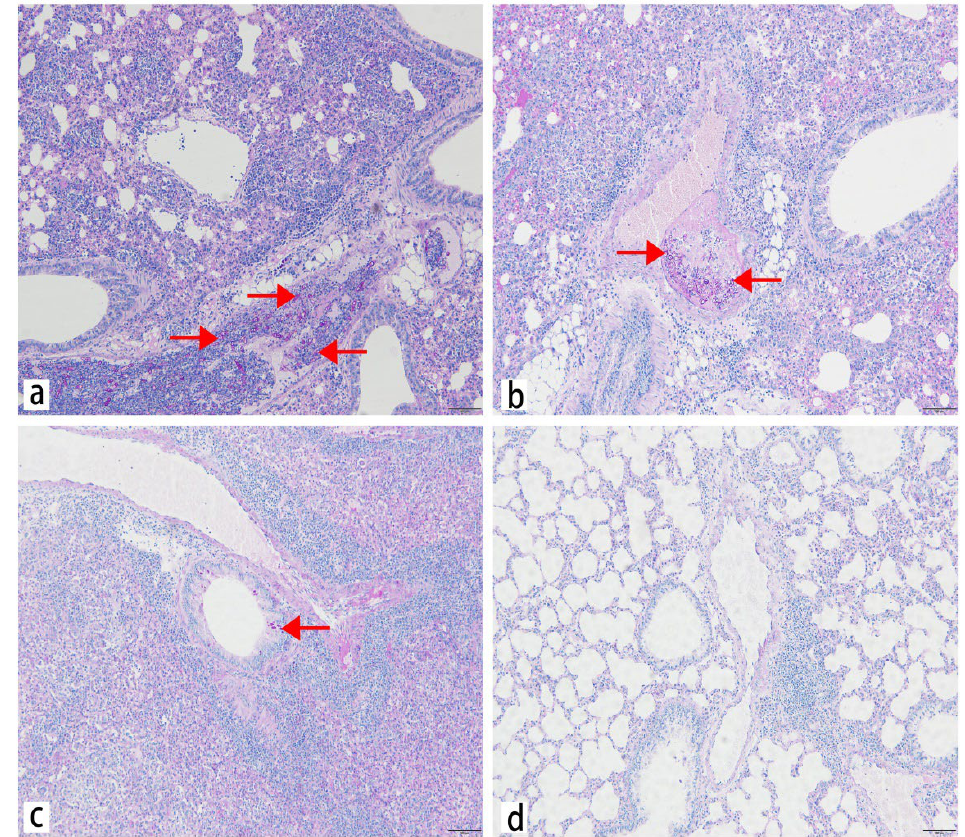
Figure 4. Representative PAS-stained sections of lung from mice on days 2 ( a ), 5 ( b ), 9 ( c ), and 14 ( d ) after infection; i.v. infected with M. gypseum (4 × 10 6 CFU/mL). The fungal colonization in mice infected with M. gypseum after infection on days 2 ( a ), 5 ( b ), 9 ( c ) is shown. The alveolar septa and bronchus were colonized by dermatophyte arthroconidia in the lung. The spores are indicated with arrows. Scale bars, 500 μm.